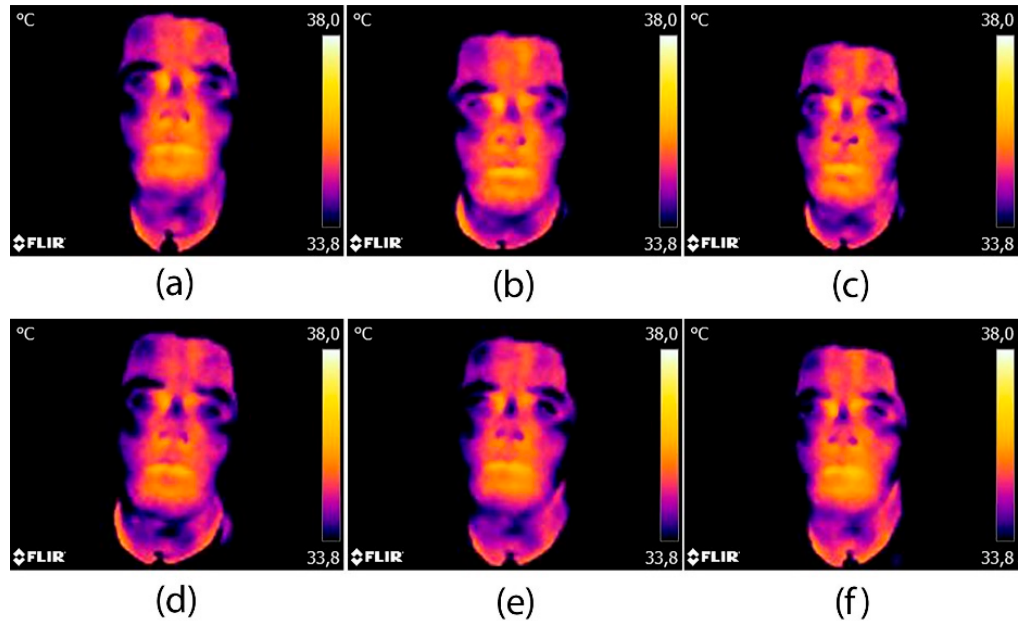
Figure 7. Example of a temporal series of thermographic images for the anger emotion: ( a ) beginning of stimulus; ( b ) 4 min of stimulus; ( c ) end of stimulus and beginning of the response period; ( d ) one minute after the stimulus; ( e ) six minutes after the stimulus; ( f ) ten minutes after the stimulus (end of recovery period).